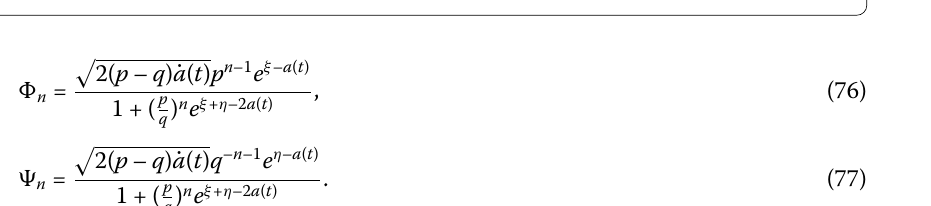
Figure 1 One soliton of u n , w n , (cid:8) n , and (cid:9)